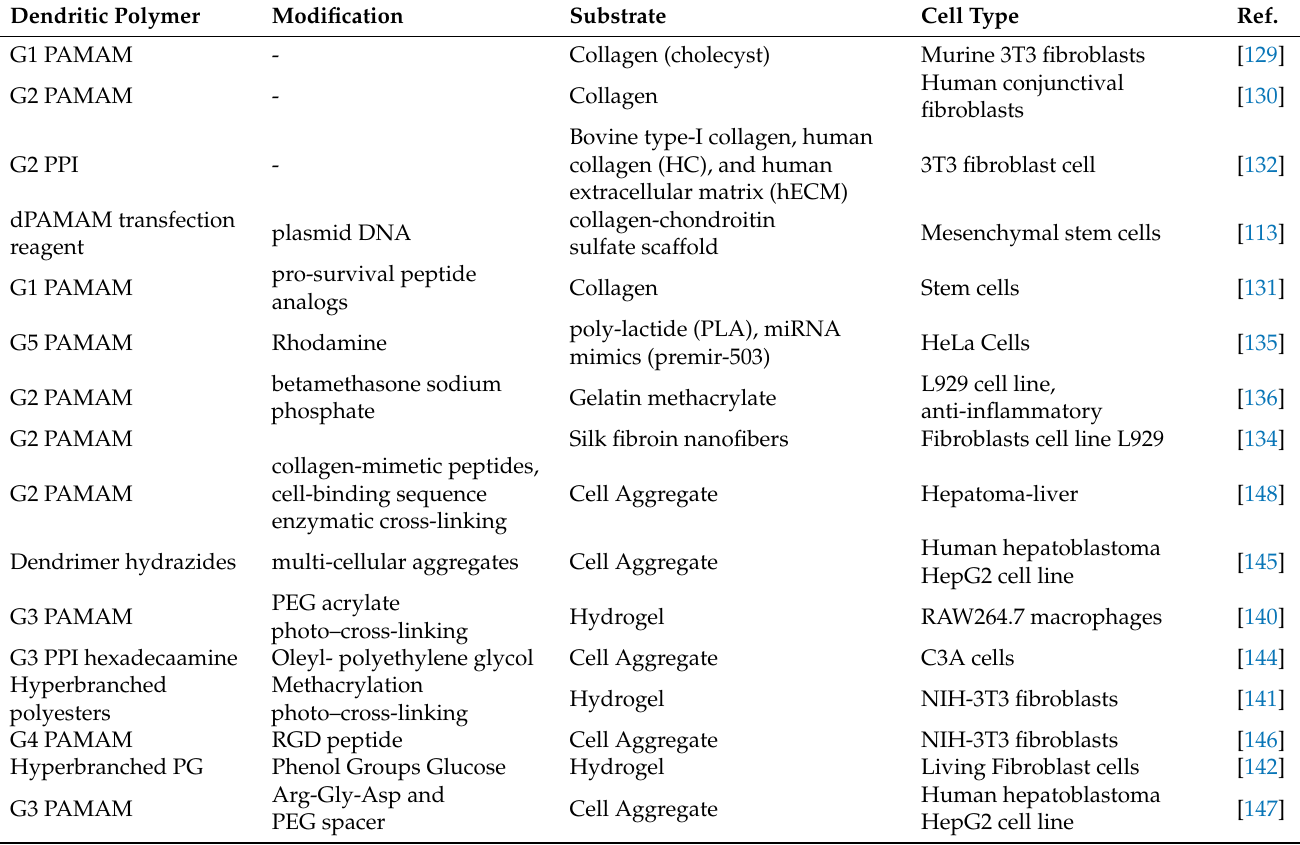
Table 2. Dendritic Polymers that promote cell adhesion, organization, proliferation, and differentiation. Dendritic